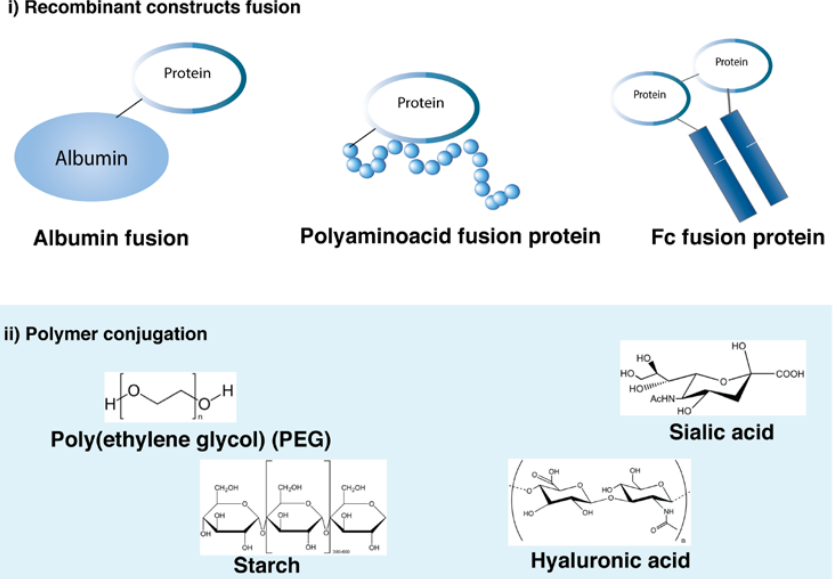
Figure 5. Methods to increase the duration of action of proteins.